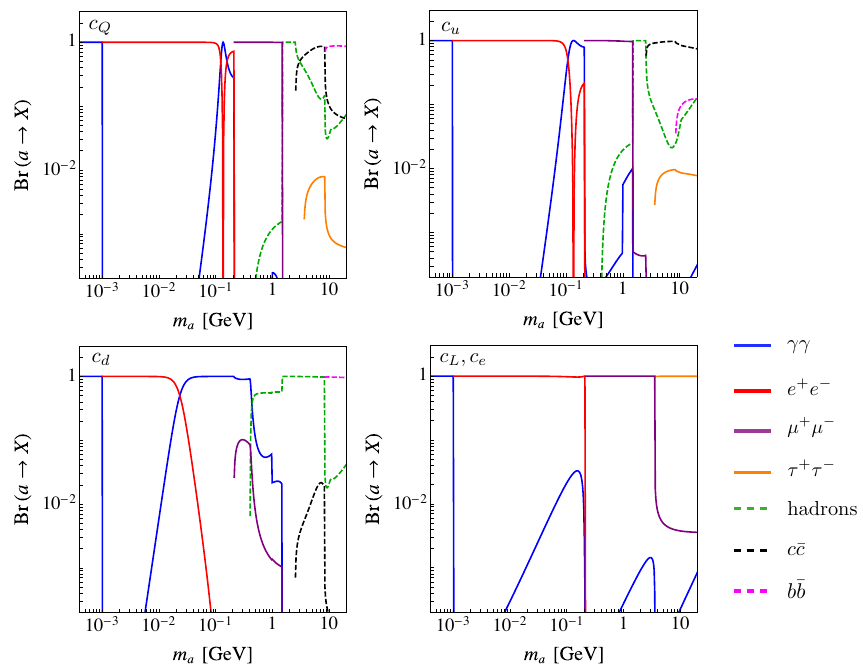
Figure 18 . Branching ratio for an ALP with couplings to either c Q (top left), c u (top right), c d (bottom left), c and c (bottom right) at Λ = 4 πf and f = 1 TeV. The branching ratios of the L e ALP into photons and charged leptons are indicated by solid lines and the branching ratios of the ALP into hadronic states are given by dashed